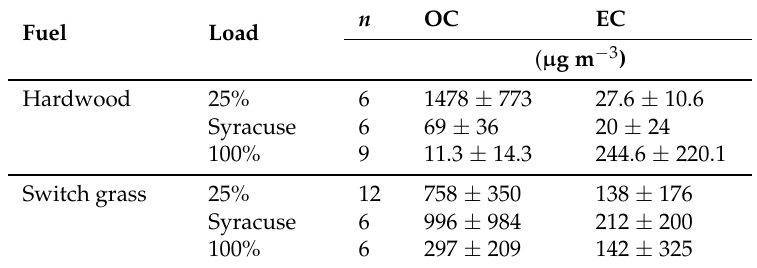
Table 3. Mean, standard deviation, and range of OC and EC concentrations in emissions from the BB testing. n OC EC Fuel Load ( µ g m − 3 ) Hardwood 25% 6 1478 ± 773 27.6 ± 10.6 Syracuse 6 69 ± 36 20 ± 24 100% 9 11.3 ± 14.3 244.6 ± 220.1 Switch grass 25% 12 758 ± 350 138 ± 176 Syracuse 6 996 ± 984 212 ± 200 100% 297 ± 209 142 ±